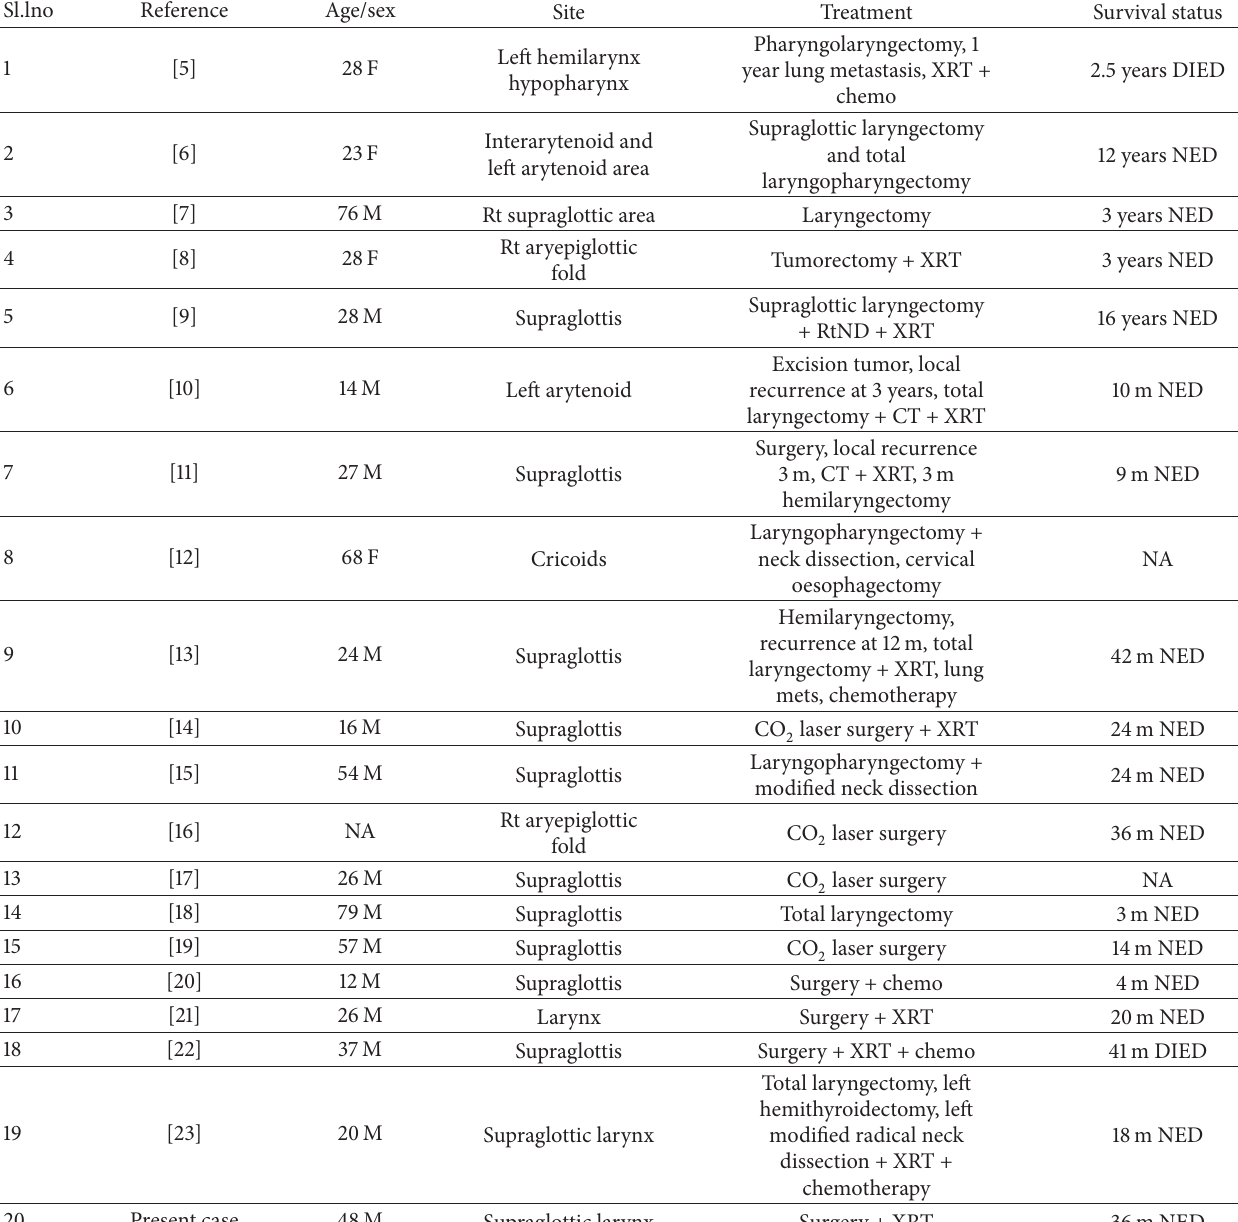
Table 1: Review of literature of synovial sarcoma of